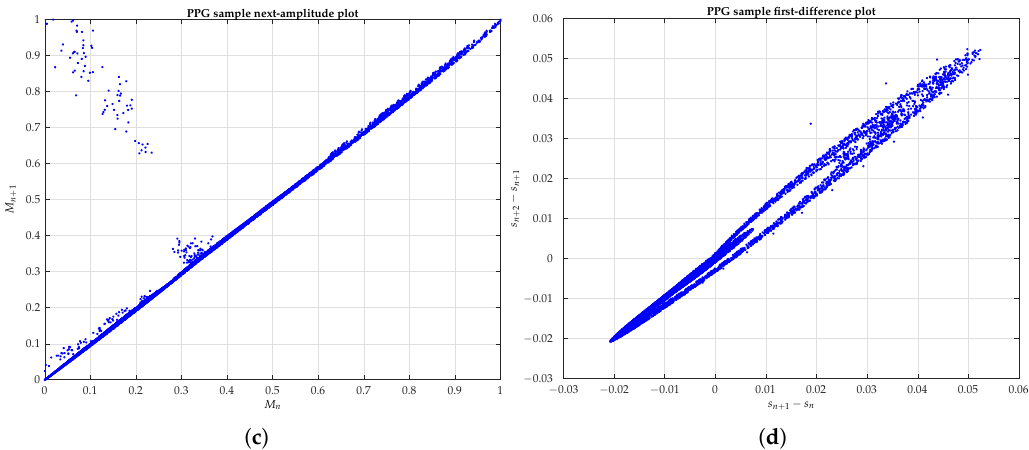
Figure A2. From a sample PPG signal and for τ = 1: ( a ) 2D phase diagram; ( b ) 3D phase diagram; ( c ) successive-maxima plot; ( d ) difference plot.